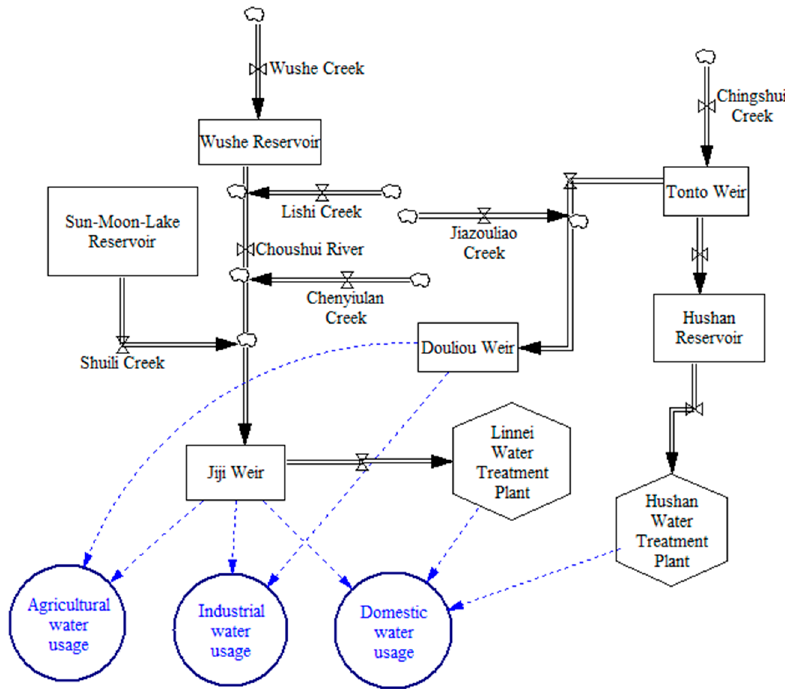
Figure 2. The water supply system dynamics model for the water resources allocation in Chuoshui River watershed.